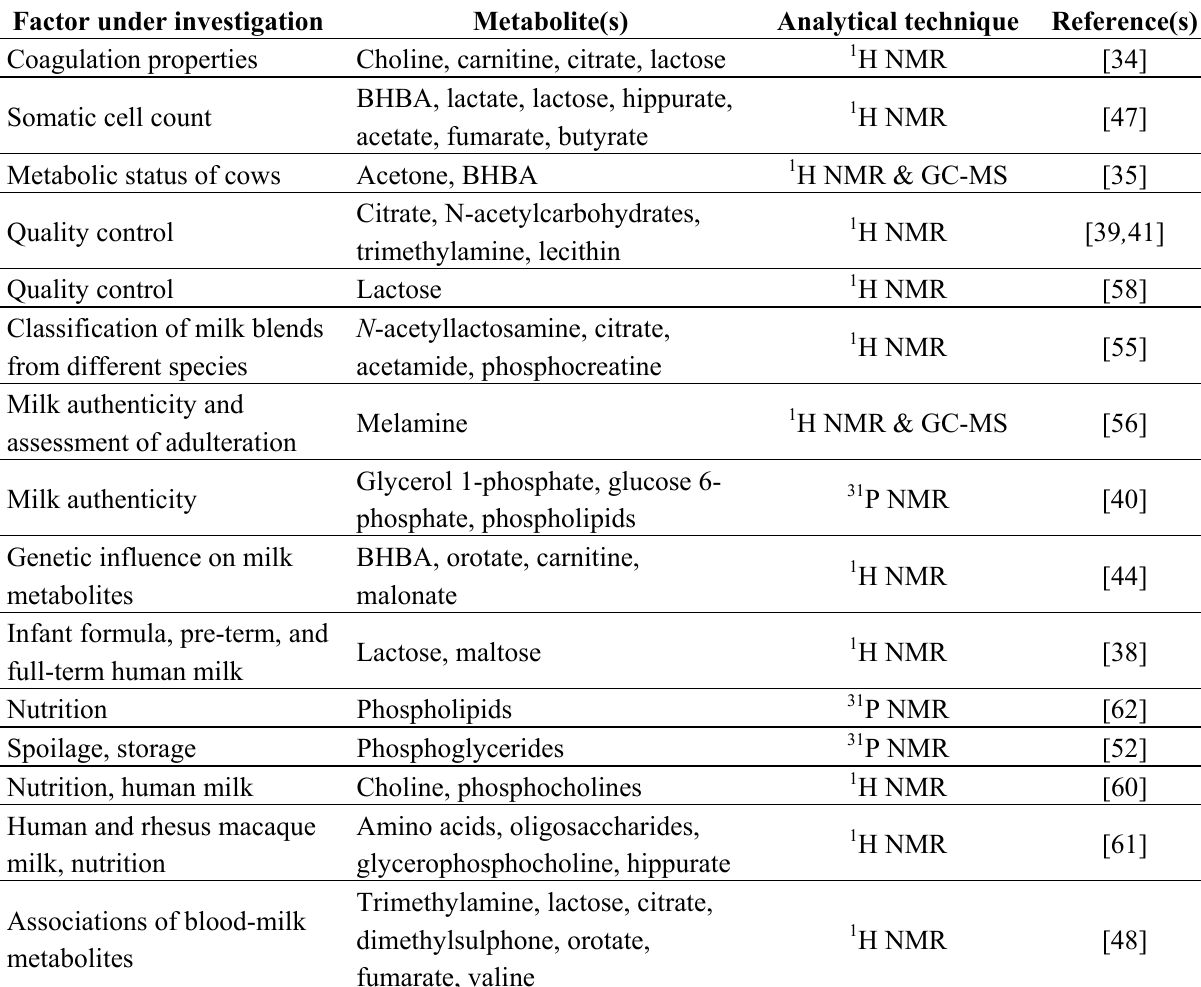
Table 2. A summary of milk NMR-based metabolites and metabolomic studies reported